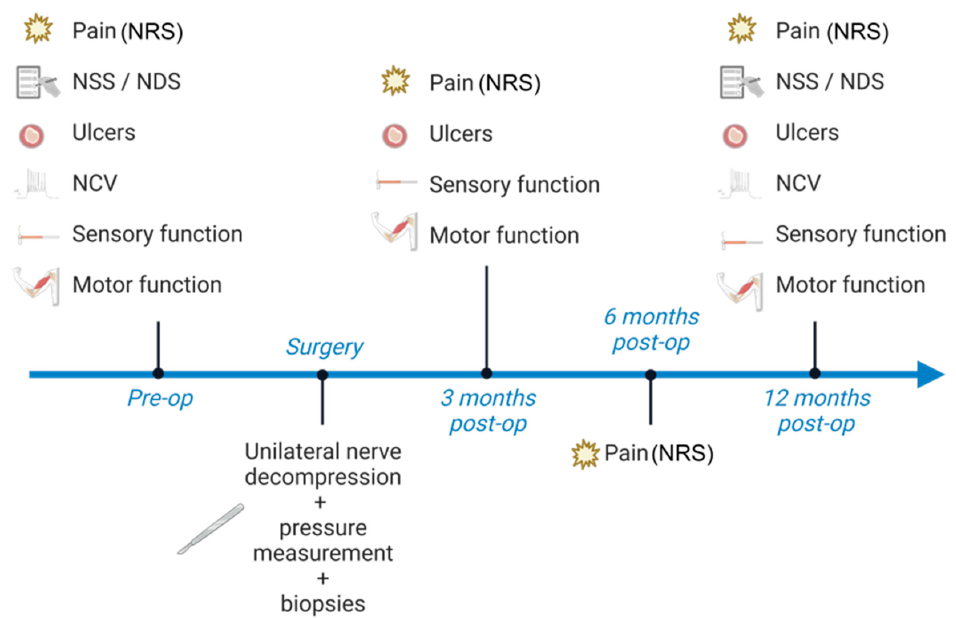
Figure 3. Participant timeline. Preoperatively, participants undergo detailed pain anamnesis with pain intensity scoring on the numeric rating scale (NRS), conduct the neuropathy symptom score (NSS) and neuropathy deficit score (NDS), and are screened for ulceration in the skin areas supplied by the tibial and peroneal nerve. Further, electrodiagnostic testing is conducted to measure nerve conduction velocity (NCV) and participants undergo tests for sensory and motor function. Three months post-surgery, pain intensity, ulcerations, and motor and sensory function are re-examined. Six months post-surgery, participants are asked to score their pain intensity. Twelve months post-surgery, the pre-operative set of tests is